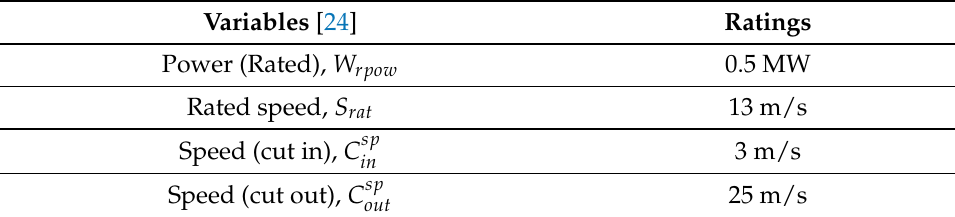
Table 2. Parameters of